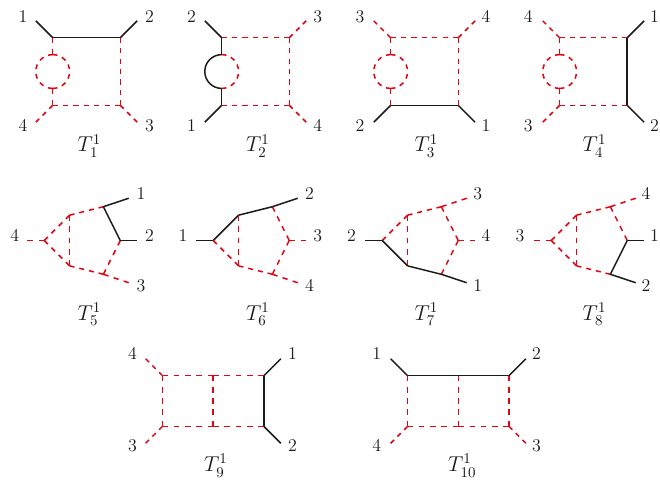
part of planar two-loop ¯ ttgg amplitude. Black-solid lines c